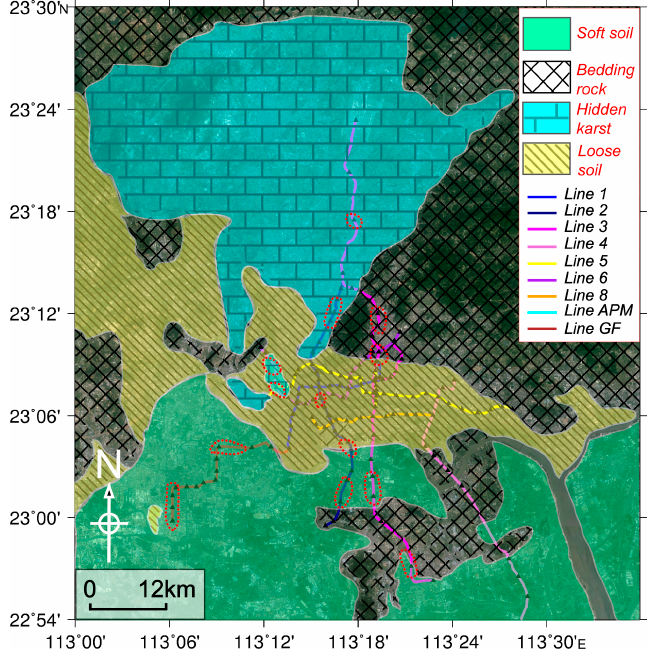
Figure 12. The geological formation, including soft soil, loose soil, hidden karst, and bedding rock, of the Guangzhou subway network. Red dotted circles represent the location of the subsiding areas discussed in Section 3.